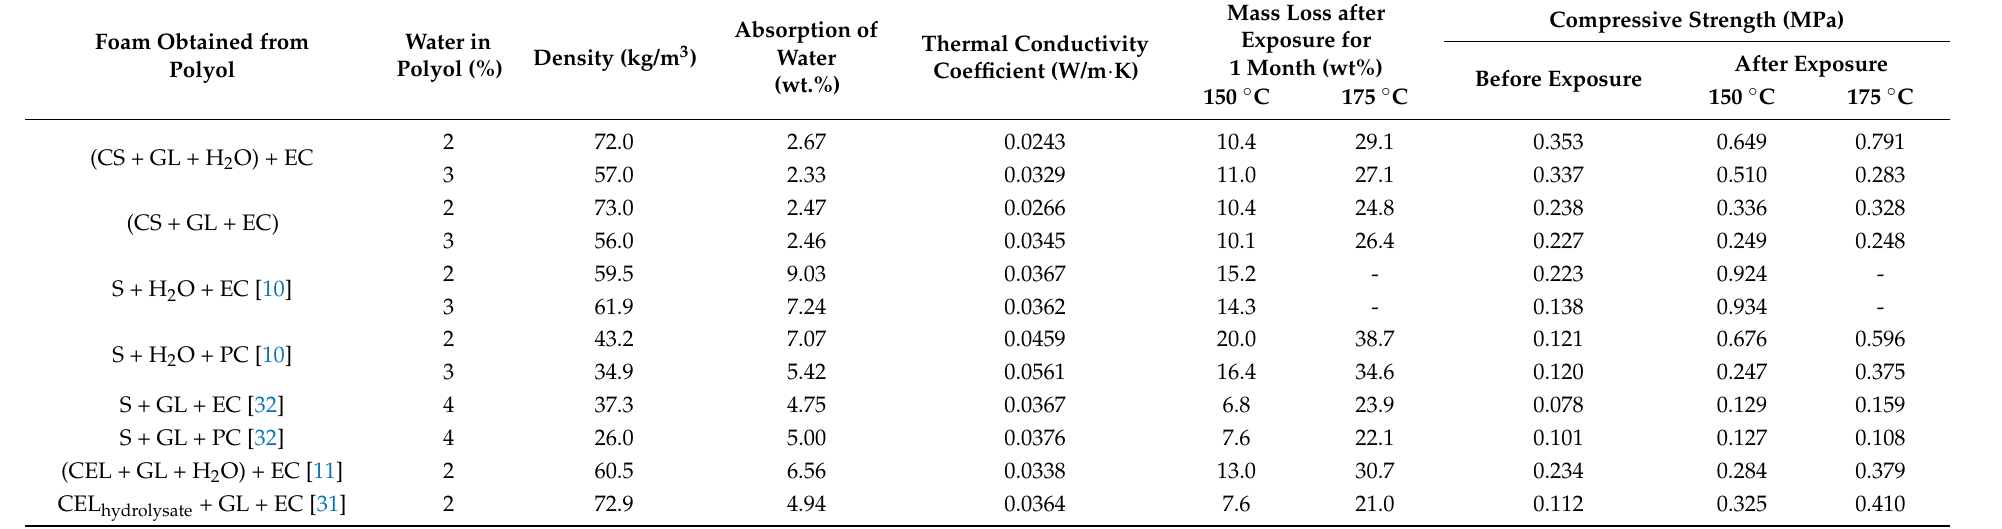
Table 12. Comparison of properties of PUFs based on natural